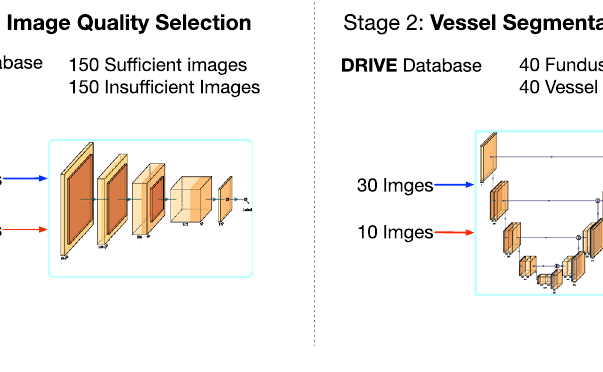
Figure 2. Each stage can be trained separately. Compared with end-to-end structure, this multi-stage pipeline has an advantage as being modular where each stage can be trained independently with various databases. This advantage could be highly valuable when this pipeline needs to be applied to a new database and only one or two stage needs to be